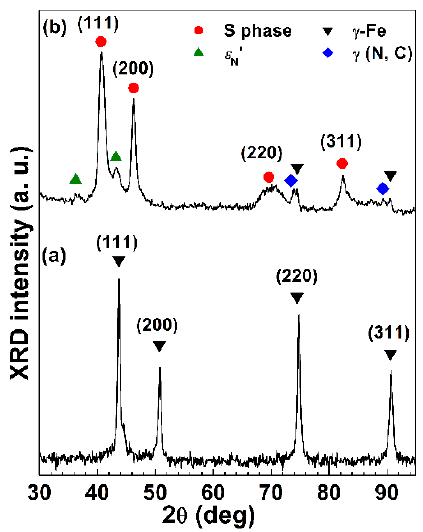
Figure 5. X-ray diffraction patterns of AISI 316L samples: ( a ) untreated; ( b ) plasma nitrided at 380 °C, 340 Pa, 3 h (Bragg-Brentano configuration, Cu K α radiation). For further experimental details, see [70].